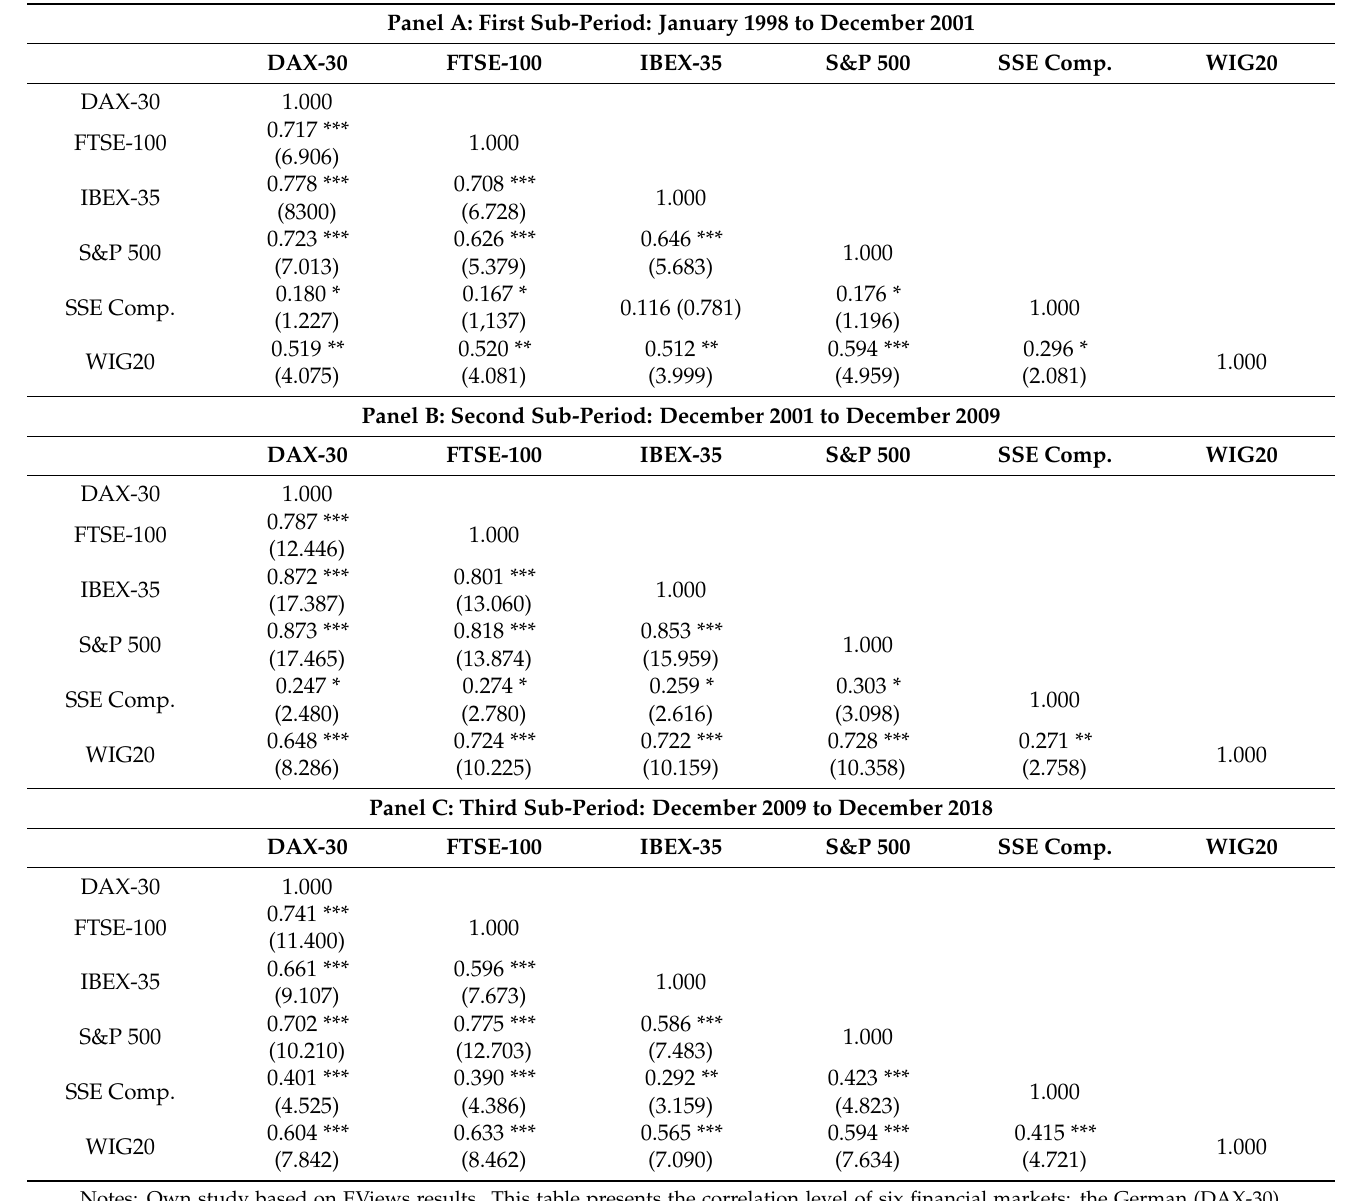
Table 3. Correlation level between log-returns of international stock markets by